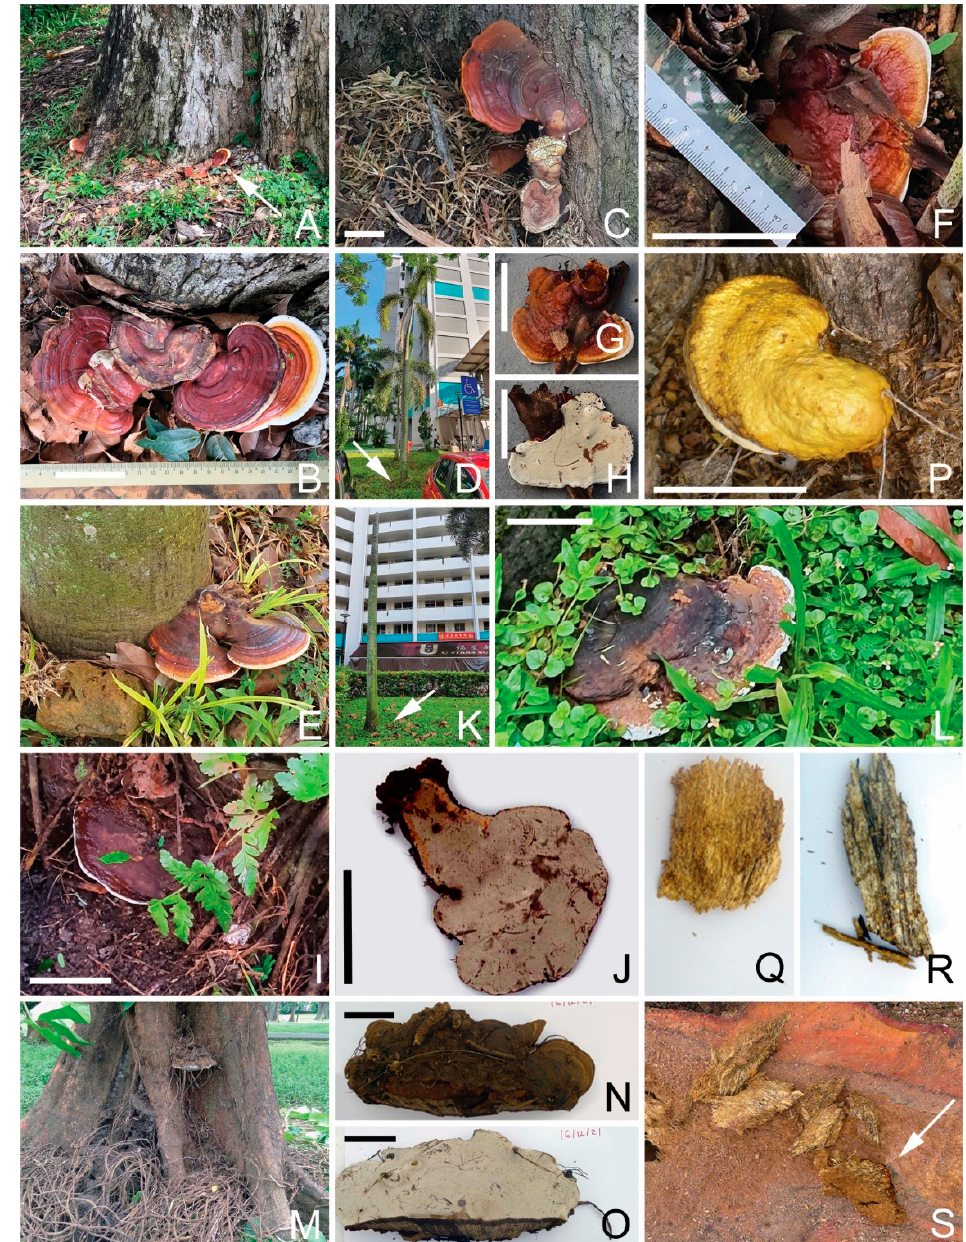
Figure 2. Ganoderma species detected in Singapore urban trees. ( A , B ): A G. tropicum fruiting body on an Angsana tree (A143); ( C ): a G. tropicum fruiting body on a Casuarina tree (CE41FB); ( D , E ): a G. orbiforme fruiting body on a Foxtail Palm (P168FB); ( F – H ): a G. orbiforme fruiting body on a Yellow Cane Palm (P172FB1); ( I , J ): a G. australe fruiting on a Yellow Cane Palm (P172FB2); ( K , L ): a bold head Foxtail Palm with G. orbiforme fruiting body at base (P174FB); ( M – O ): a big G. australe fruiting body from a Casuarina tree (CE153FB); ( P ): a Tomophagus colossus fruiting body on an Angsana tree (A126); ( Q ): a decayed wood by G. australe (CE149DT4); ( R ): a decayed wood from the same tree by Fulvifomes siamensis (CE149DT5); ( S ): a Casuarina stump (CE149) with a visible strip of decayed wood (arrowed) infected by G. australe . Bar = 5